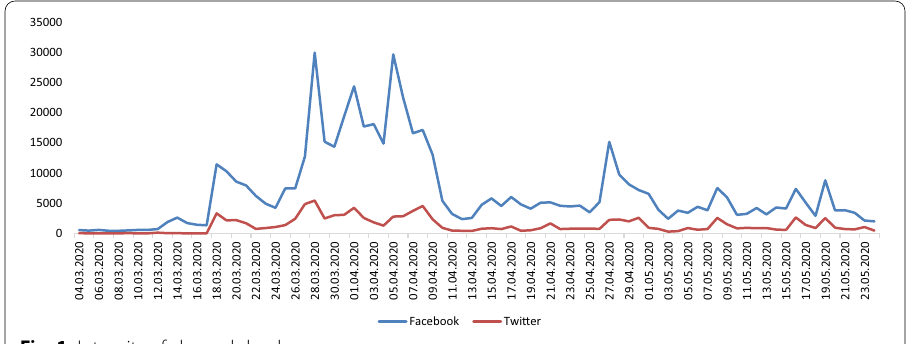
Fig. 1 Intensity of channels by